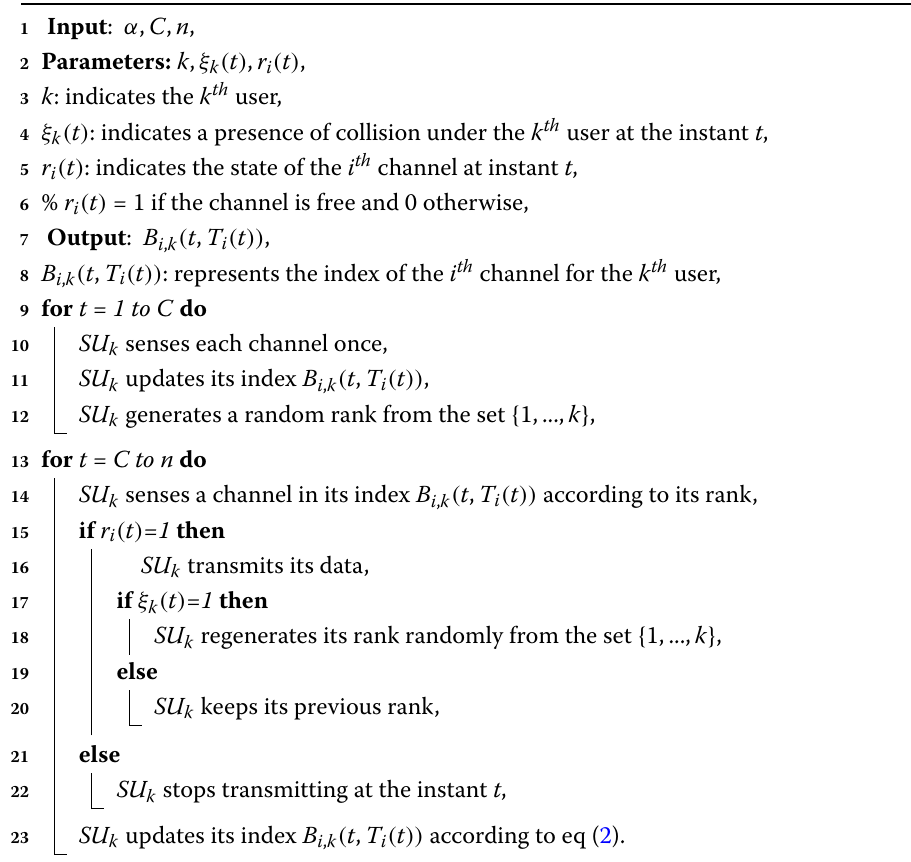
Algorithm 1: Priority Learning Policy (PLA) under